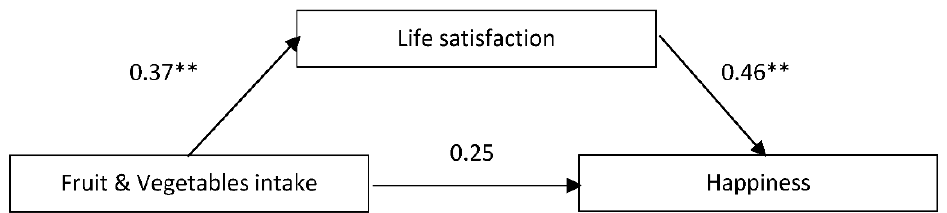
Table 5. Indirect mediational effects.